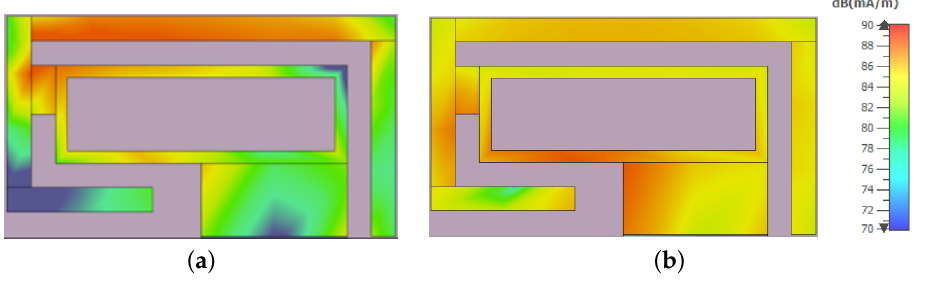
Figure 3. Surface current distribution at ( a ) 3.5 GHz; ( b ) 5.4